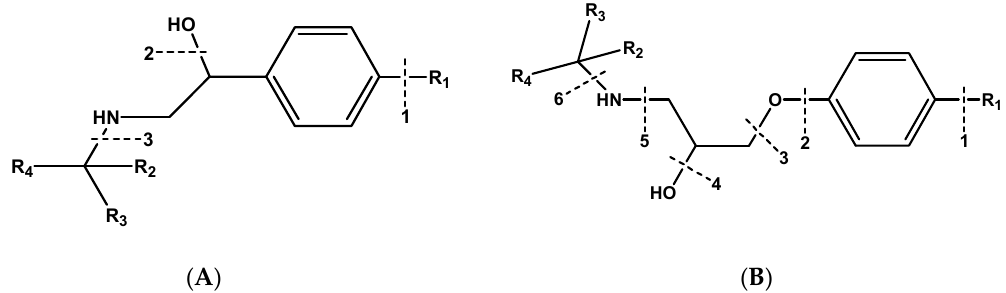
Figure 3. Principal structure of ( A ) phenylethanolamine compounds; ( B ) aryloxypropanolamine compounds.